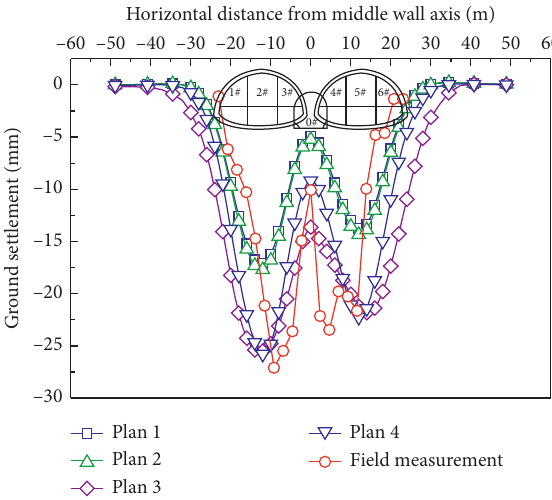
Figure 8: Traverse ground deformation of double-arch